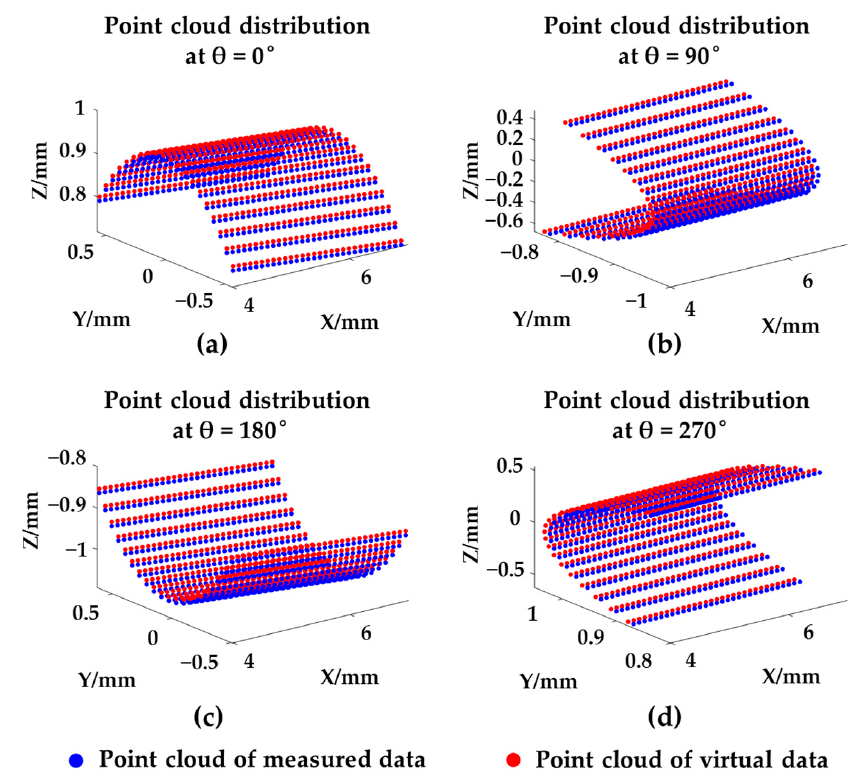
Figure 6. The point cloud distribution of the rotary axis calibration in simulation: ( a ) θ = 0 ◦ ; ( b ) θ = 90 ◦ ; ( c ) θ = 180 ◦ ; ( d ) θ = 270 ◦ . The coordinate system O ’ -X ’ Y ’ Z ’ of the rotary stage did not coincide with the measure- ment coordinate system O-XYZ. Coordinates of the direction vectors O ’ X ’ , O ’ Y ’ , O ’ Z ’ , and the origin O ’ in O-XYZ can be expressed according to the static errors of the rotary stage. By using the coordinate space transformation matrices, the coordinates of the measured point P ’ can be converted to the coordinates P in the global measurement coordinate system: